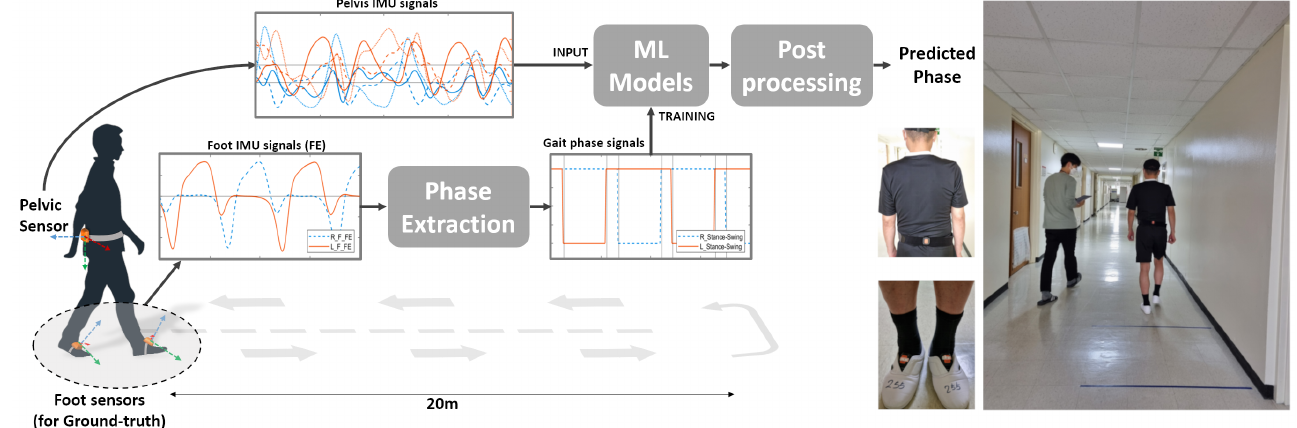
Figure 1. Overview of the proposed phase detection method and the experiment used for data acquisition. Images on the right show the actual sensors and the experiment being carried